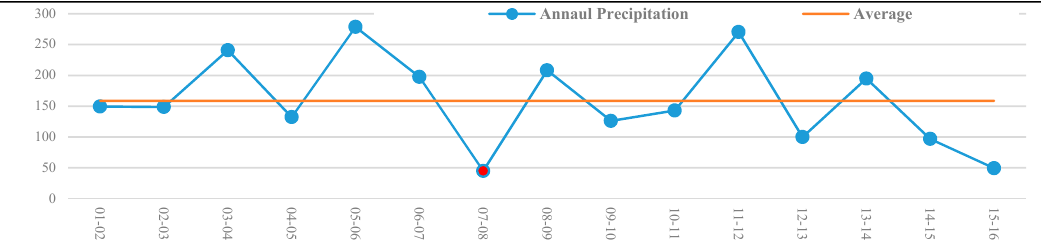
Figure 6. Comparison of annual precipitation fluctuations in the studied area with the long-term average.